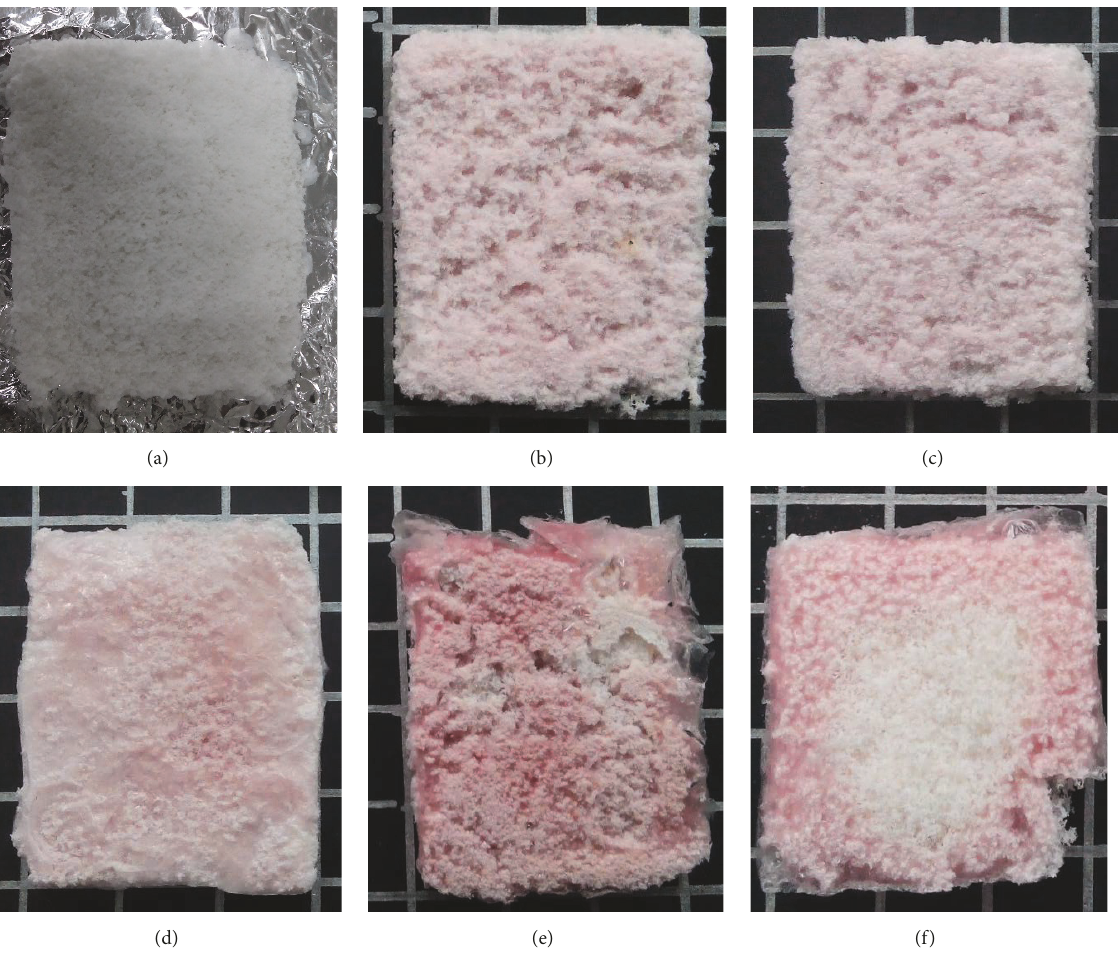
Figure 4: Aerial view of the red dye stained 3D scaffolds postinfusion of 5 different carrageenan concentrations: (a) control (naked 3D scaffold); (b) infusion of 2% (w/v) carrageenan solution; (c) infusion of 4% (w/v) carrageenan solution; (d) infusion of 6% (w/v) carrageenan solution; (e) infusion of 8% (w/v) carrageenan solution; and (f) infusion of 10% (w/v) carrageenan solution.